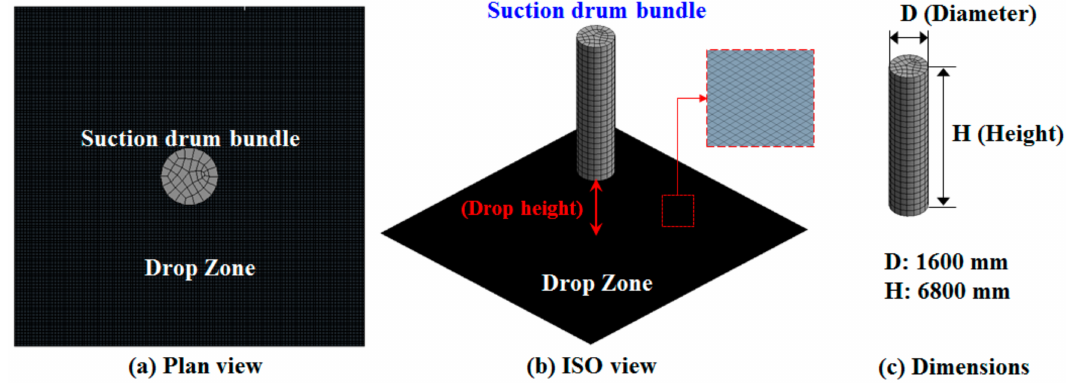
Figure 23. FE model for drop impact